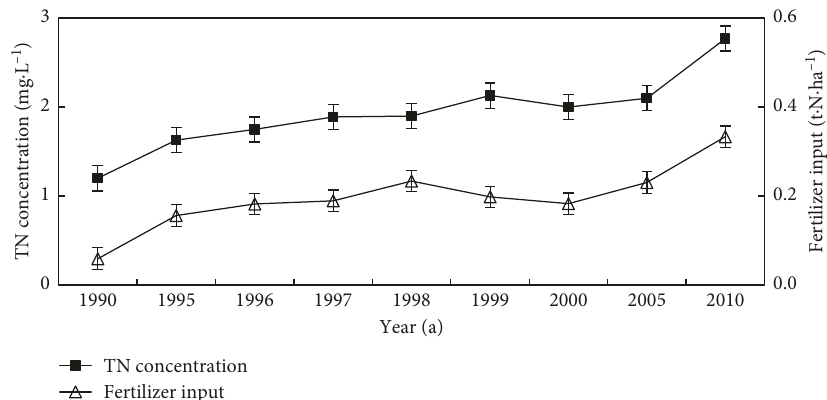
Figure 7: Chemical fertilizer input and TN content of water in Changshu from 1990 to 2010.